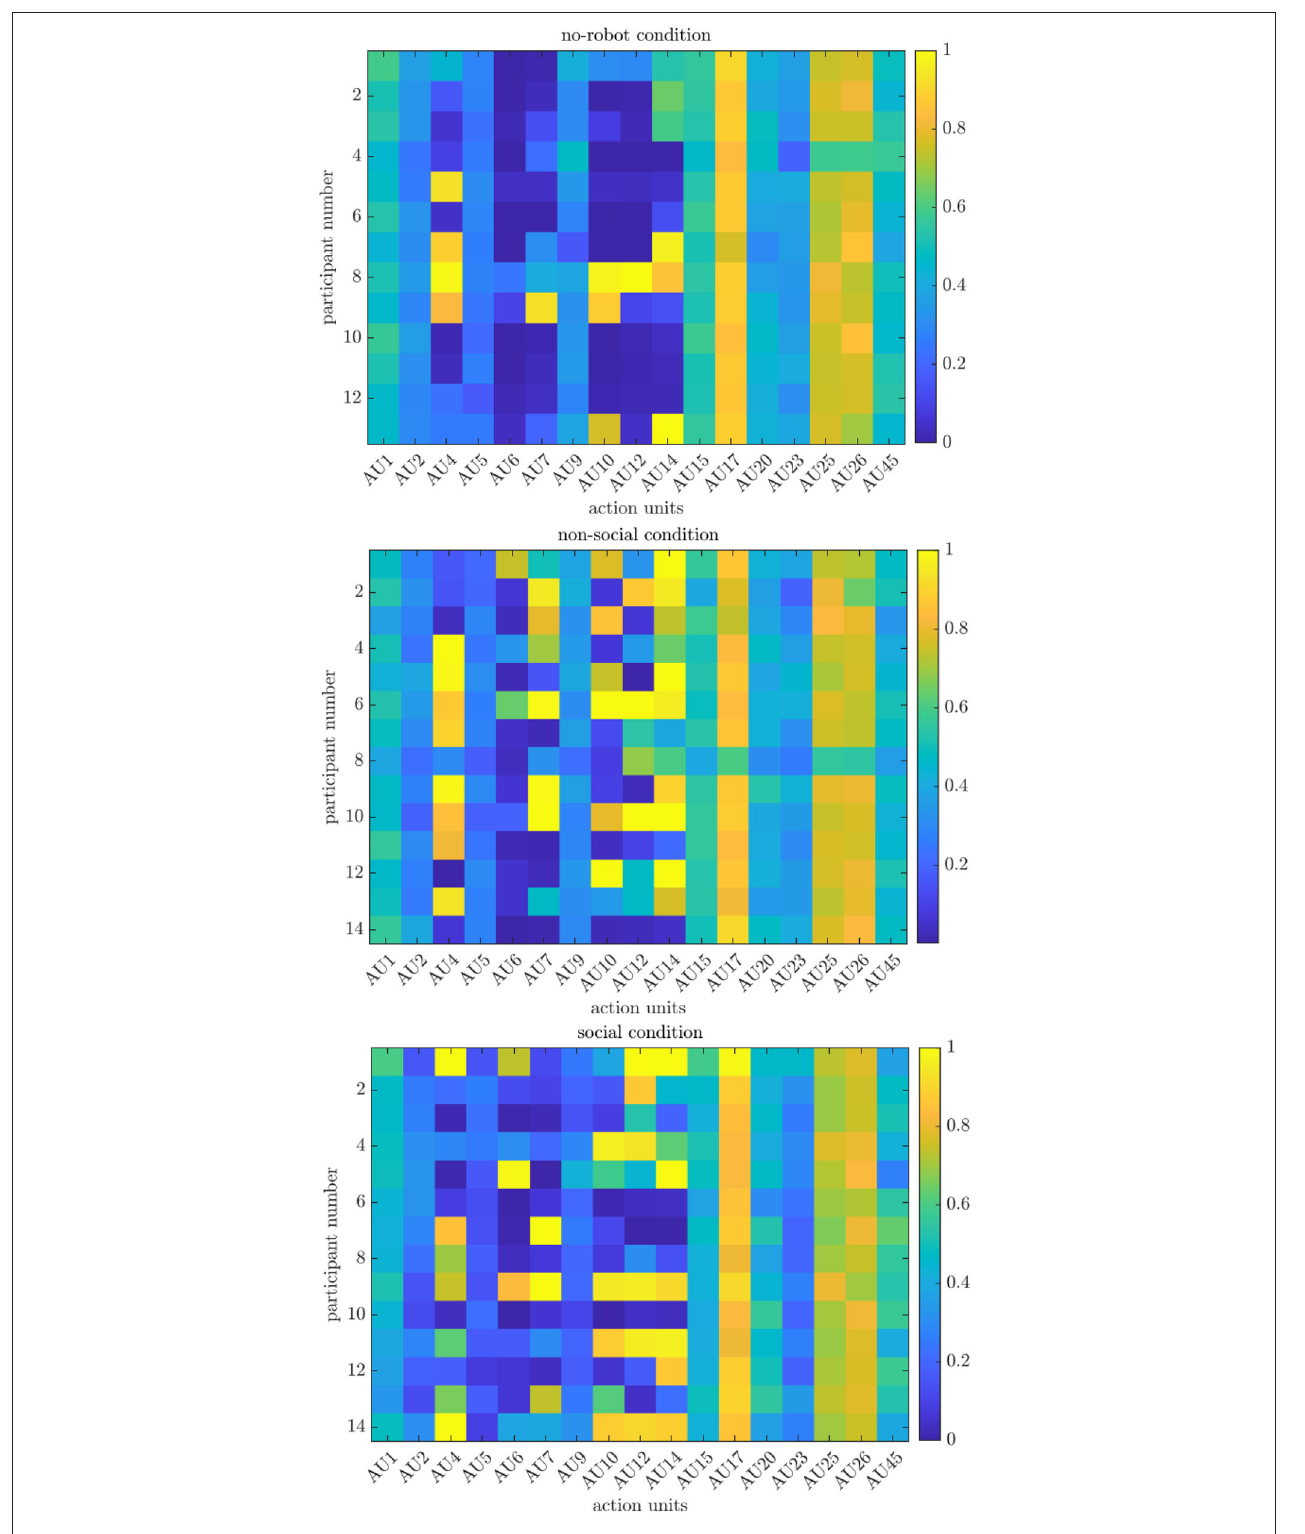
FIGURE 6 | Normalized heat maps of action unit intensity levels over all participants for all experimental conditions.